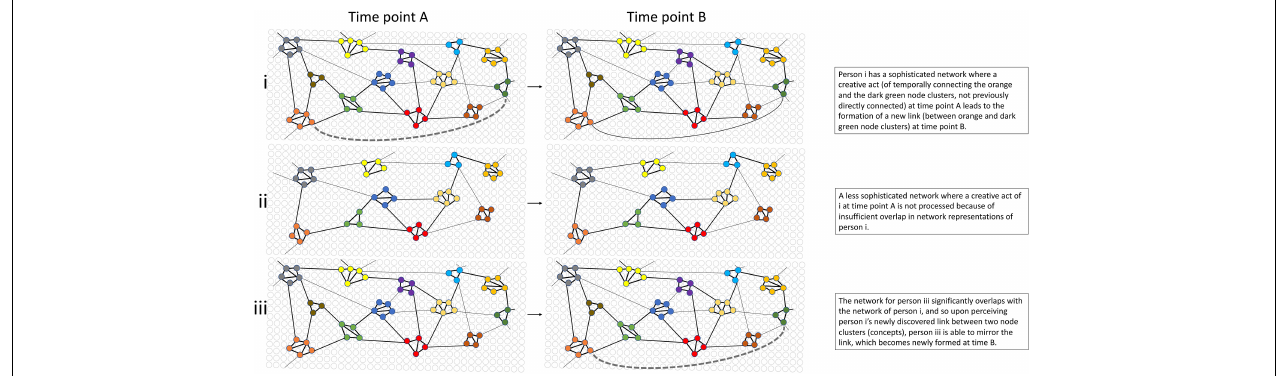
FIGURE 2 | Network representations for three people at two points in time (one time point per column), illustrating the spreading activation model of creativity (SAMOC). It shows clusters of nodes organized into coherent sematic and sequential encoding of objects/events and thoughts, with single colors of closely packed nodes (node clusters) representing a coherent concept, object, or event, and lines between nodes indicating the link strength, with thicker lines indicating stronger links, and therefore a greater propensity to prime or activate an adjacent node, which then spreads through the network according to the weightings of links to adjacent nodes. The dotted line indicates the formation of a new connection between existing node clusters (“transcombination”), either as a result of creative thought or through perception of the newly combined concepts, objects, or events. (i) depicts the network for a person who has just made a novel link between two never-before combined ideas (the concepts/objects/events represented by the orange and the dark green node clusters), and so a new link is forming [dotted line in network (iA)]. Over time, the repeated thought or exposure to the new combination strengthens the link between the node clusters (time point B). The new link can be formed through an intermediate node, or directly between the node clusters (the latter shown in the illustration for simplicity). The network for person (ii) indicates that this person only shares a small number of concepts that person (i) has, and so is unable to process the creative, new link achieved by person (i) . At time B person (ii) has had no noticeable change in their network, and so will not experience additional activation as a result of being exposed to the newly combined ideas, leading to a non-positive affect experience. Person (iii) on the other hand has considerable overlap in mental representations with person (i) and so is also able to form a connection between the newly combined clusters (orange and dark green), with the newly forming links appearing at time point B, mirroring that experience by person (i) at time point A, and leading to additional activation which generates positive affect (pleasure). The experience for person (i) and person (iii) is considered creative because previously unlinked nodes have been combined for the first time and generate positive affect. Furthermore, the existing pathways prior to their being combined was relatively distant in terms of the number of nodes that needed to be traversed, and the net, effective link strength. Hence, the greater the separation between nodes (or node clusters) in terms of intermediate nodes and low net link strength, the greater the perception of novelty. There are of course several pathways through which one node can be connected to another distant node in the network, and this is characteristic of the complex dynamic creative system being